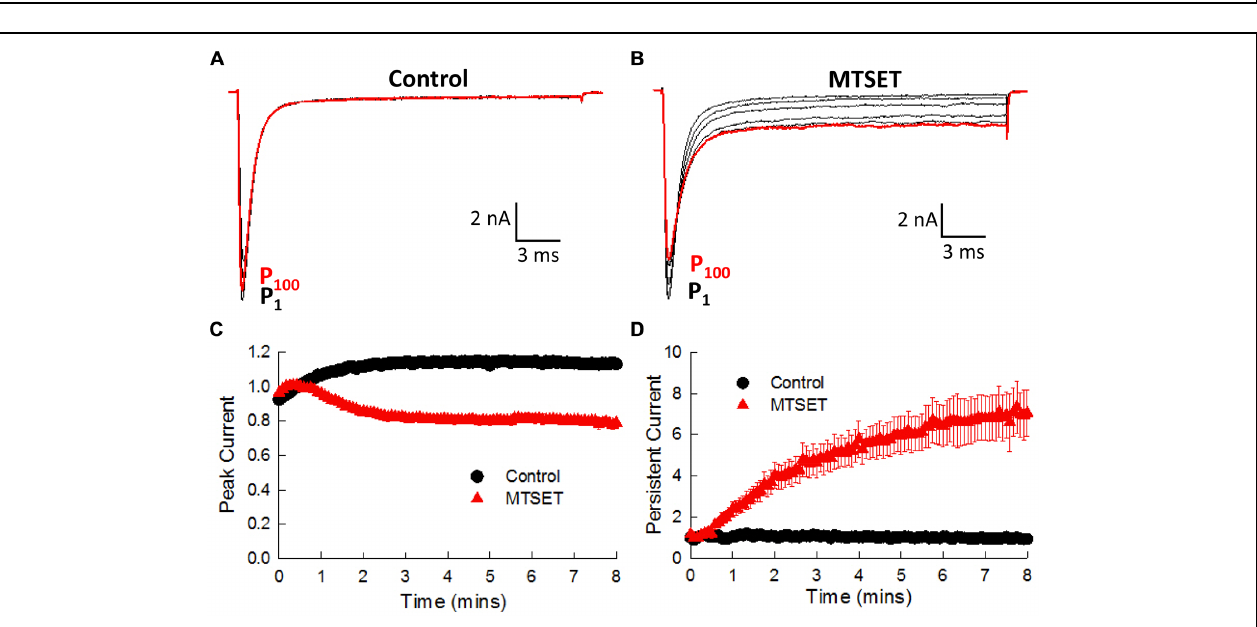
FIGURE 6 | Methanethiosulfonate reagent inhibition requires fast inactivation. The V1763C and Y1767C mutations were transferred to an inactivation deficient background of Na v 1.5 created by replacing the conserved F1486 of the interdomain D3–D4 linker with either cysteine or glutamine (see text). (A) Shows the current of the ICM mutant lacking D4S6 mutations measured during perfusion with standard pipette solution. (B) Current of the